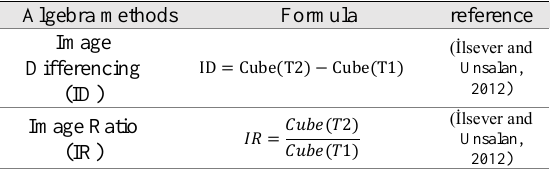
Table 2. Algebra-based